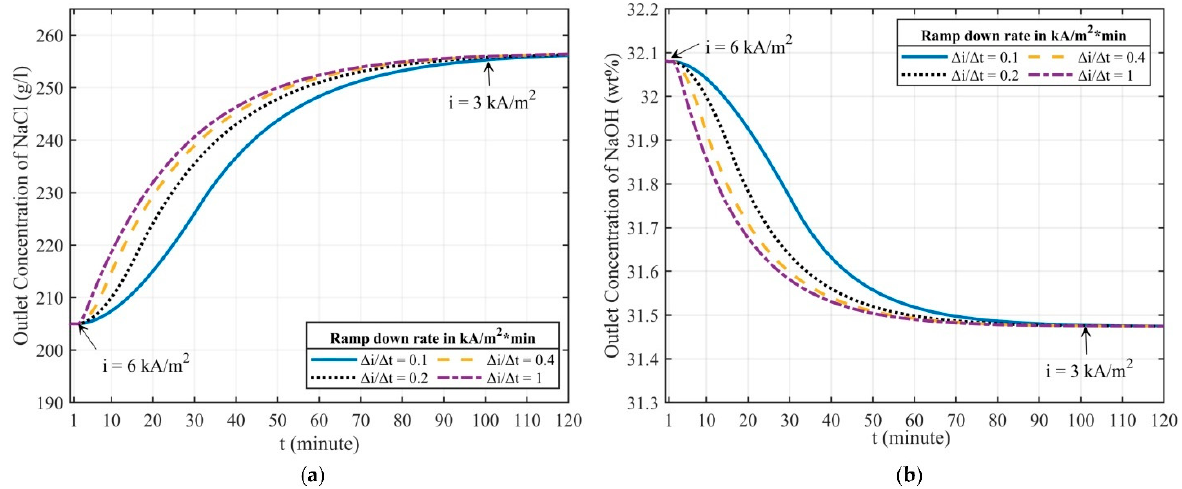
Figure 6. The outlet electrolytes concentration as a function of time in response to ramped up in current density from 3 to 6 kA m (cid:2879)(cid:2870) at time, t = 1 min , with ramp rates of 0.1, 0.2, 0.4 and 1 kA m (cid:2879)(cid:2870) min (cid:2879)(cid:2869) . ( a ) Anolyte concentration and ( b ) catholyte concentration. Operating conditions: temperature: T (cid:2911)(cid:2924)(cid:2919)(cid:2924) = T (cid:2913)(cid:2911)(cid:2930)(cid:2919)(cid:2924) = 85 °C ; electrolyte concentration: X (cid:2911)(cid:2924),(cid:2898)(cid:2911)(cid:2887)(cid:2922)(cid:2919)(cid:2924) = 300 gL (cid:2879)(cid:2869) and W (cid:2913)(cid:2911)(cid:2930),(cid:2898)(cid:2911)(cid:2899)(cid:2892)(cid:2919)(cid:2924) = 31 wt%; inlet volumetric flow rate: Q(cid:4662) (cid:2911)(cid:2924)(cid:2919)(cid:2924) = 5 L min (cid:2879)(cid:2869) and Q(cid:4662) (cid:2913)(cid:2911)(cid:2930)(cid:2919)(cid:2924) = 6 L min (cid:2879)(cid:2869) .